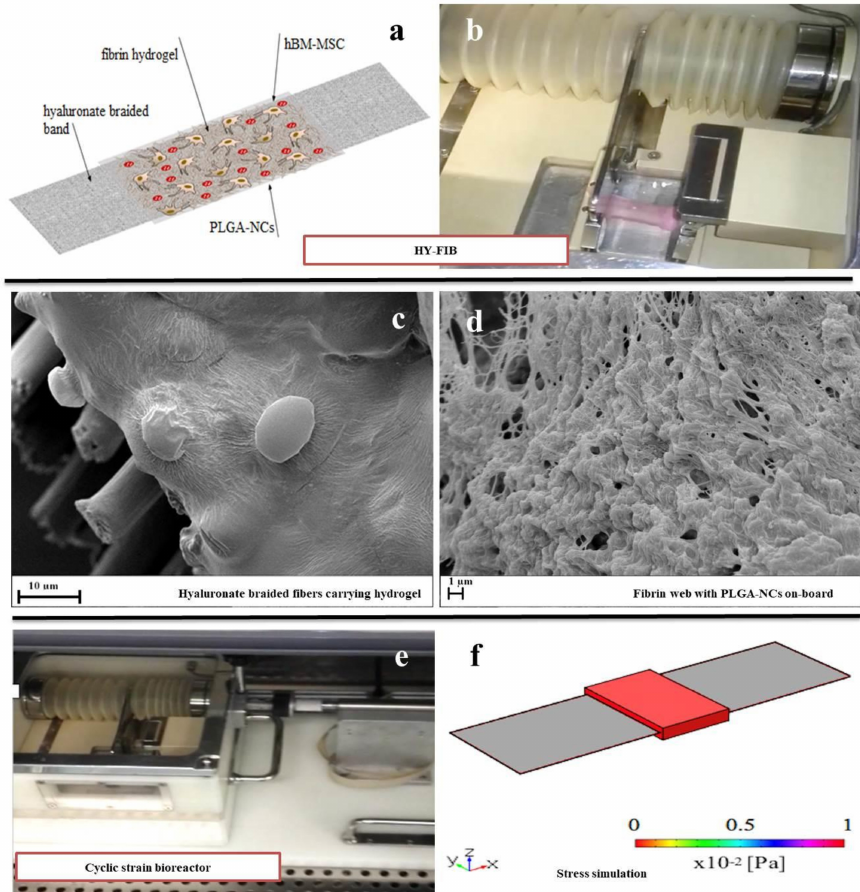
Figure 4. HY-FIB three-dimensional (3D) sca ff old features and cyclic strain bioreactor. Schematic HY-FIB representation ( a ) and image of 3D sca ff old ( b ) . SEM images of hyaluronate braided fibers (10 µ m mean diameter size) ( c ) joined to a fibrin web which entrapped both NCs and hBM-MSCs ( d ). Cyclic strain bioreactor ( e ) and in-silico study of stress distribution over HY-FIB upon mechanical strain of 10% ( f ). The simulation involved only the stress of the fibrin 3D environment, neglecting any further